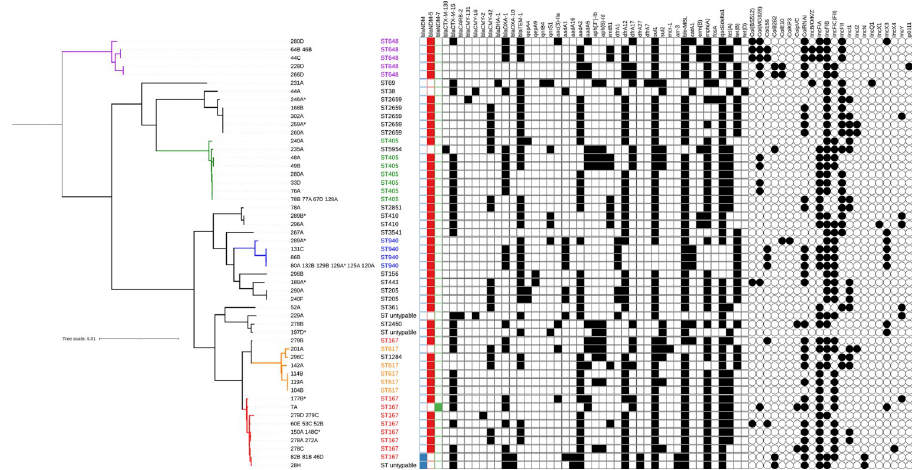
Fig 6. Phylogeny, STs, resistance genes and plasmids of E . coli . � : hospital-acquired